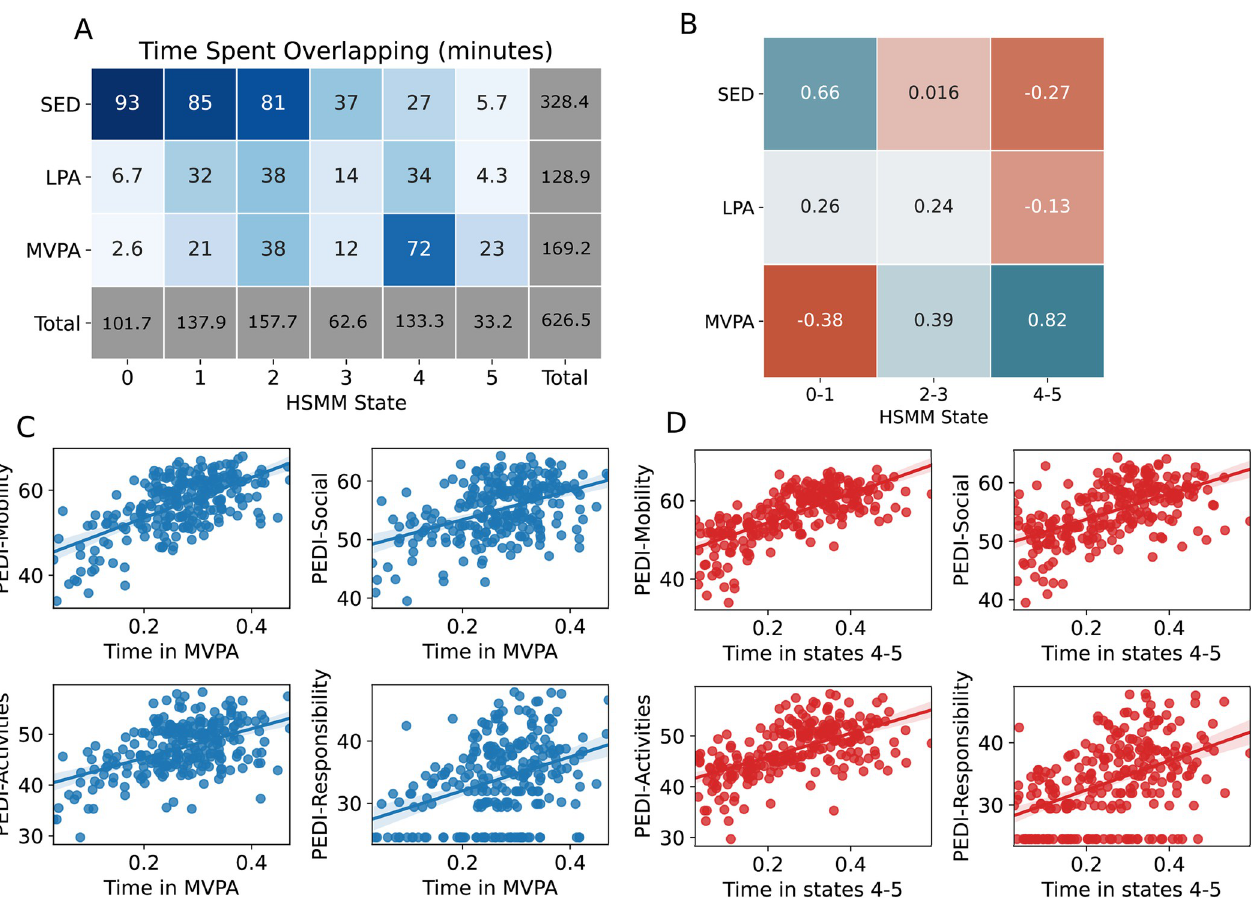
points based physical activity intensity categories compared with the time spent in the grouped states of the HSMM. (C) Shows the linear regression of time spent doing MVPA against each of the PEDI-CAT domains. (D) Shows the linear regression of time spent in states 4 and 5 of the HSMM against each of the PEDI-CAT domains.